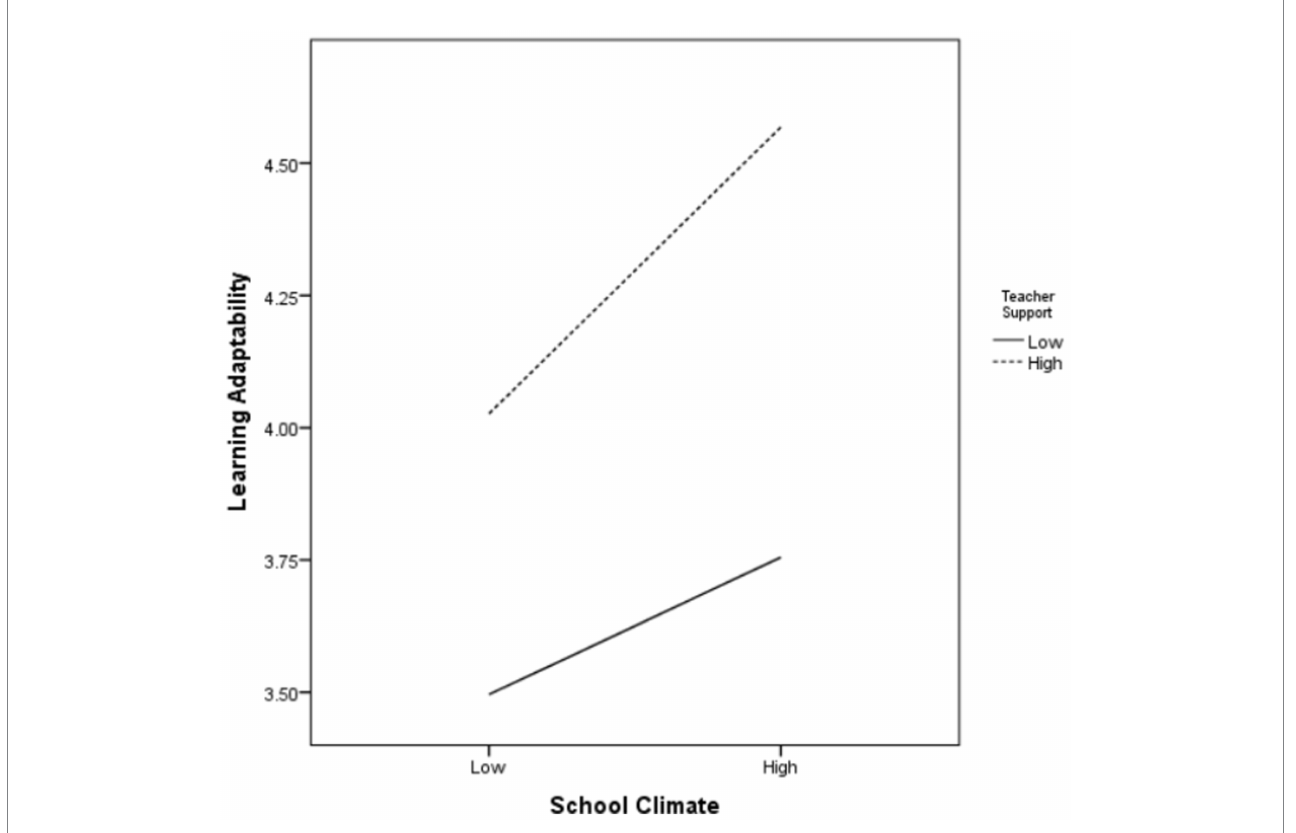
FIGURE 3 Moderating effects of teacher support on school climate and learning adaptability.